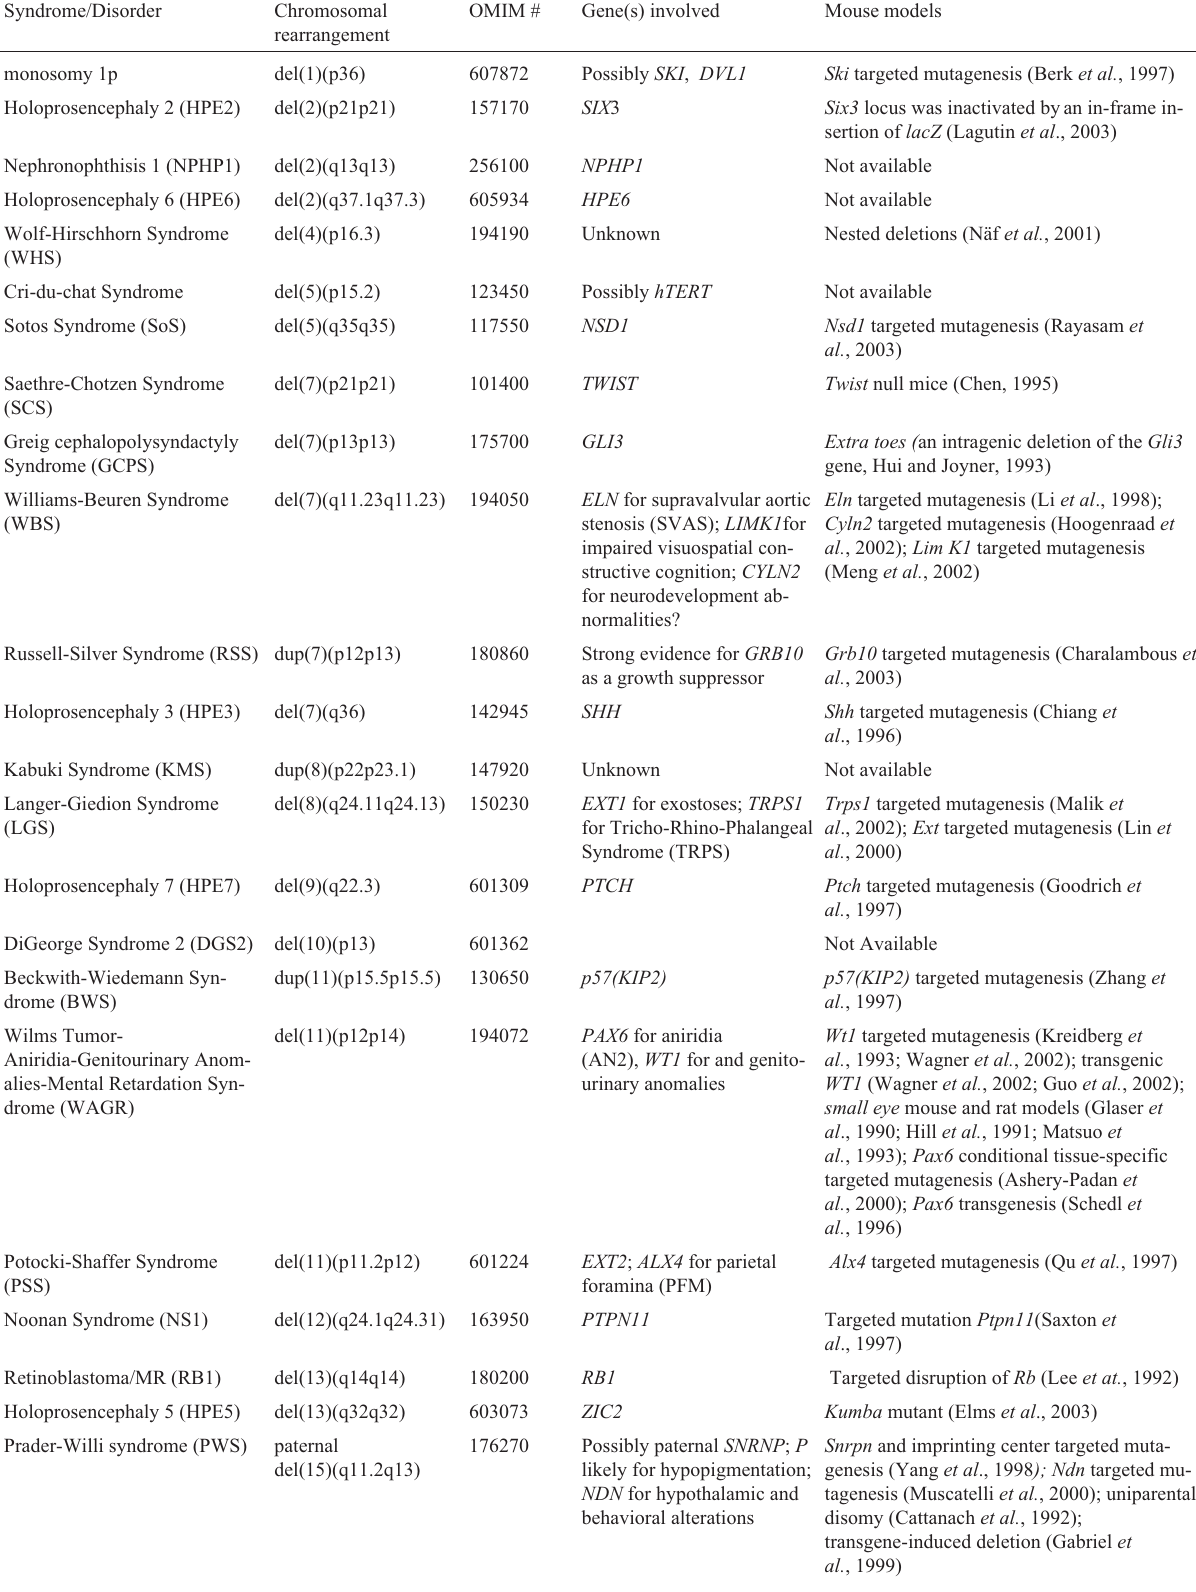
Table 1 - Contiguous gene syndromes and other genomic